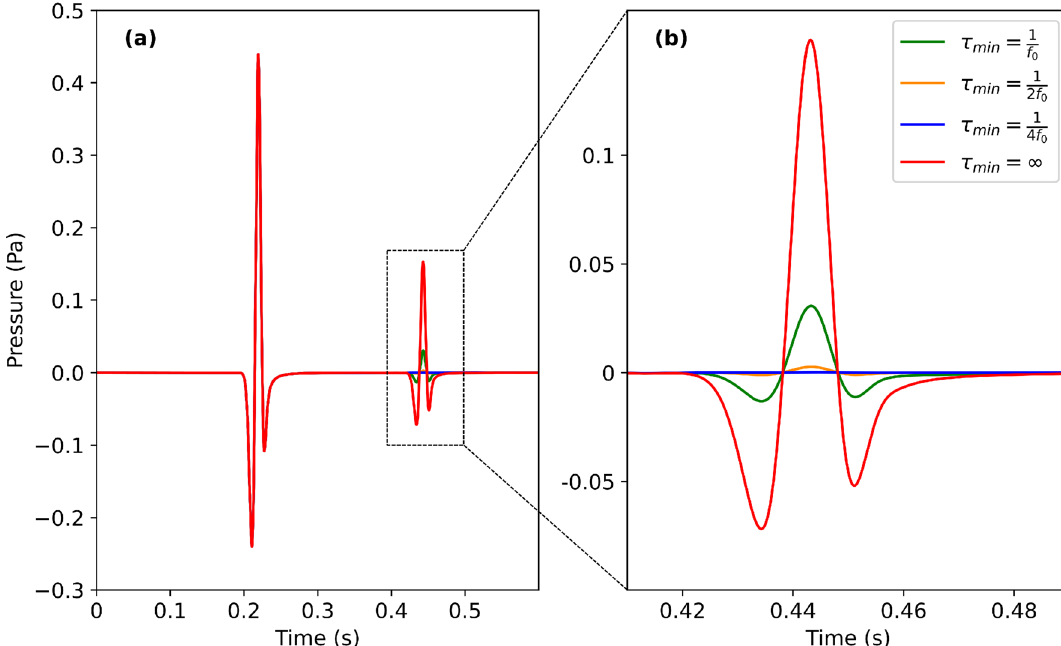
Figure 2. ( a ) The seismic trace, p ( (cid:31) r S , (cid:31) r R , t ) , obtained from the simulation of Fig. 1 from a point probe at location R (Fig. 1a) for different values of τ min . The first-arrival wave remains unaltered for all values of τ , whereas the subsequent reflected wave from the interface depends strongly on τ . Figure ( b ) highlights these suppressed reflected waves compared to the unmodified acoustic wave equation ( τ min = ∞ ). The suppressed reflections yield an amplitude loss of − 14 dB for τ min = 1 f